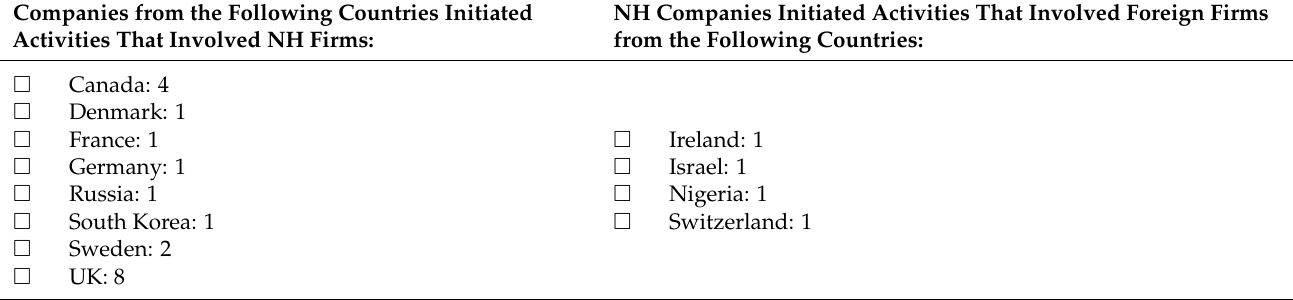
Table 5. Partnerships, acquisitions and contracts involving NH and foreign